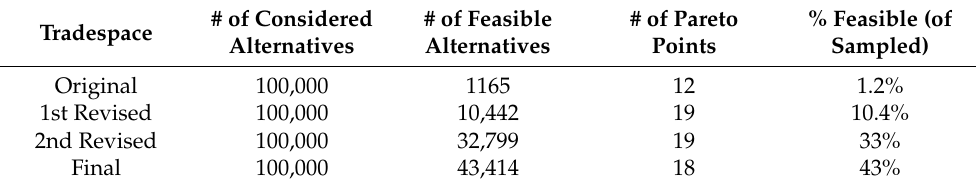
Table 4. Impact of Tradespace Refinement.